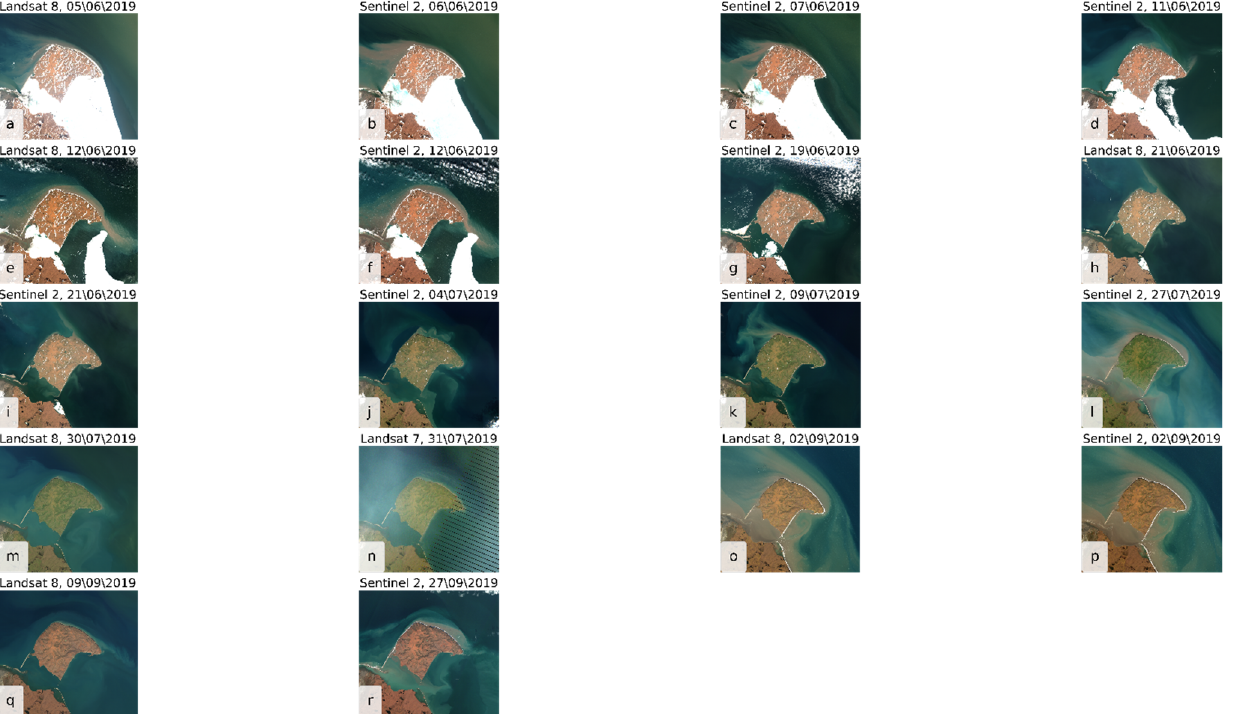
Figure A1. RGB composites of the satellite imagery similar to Figure 2. Figures a – f depict the ice break-up with increased turbidity. During mid-Summer (Figures g – n ), turbidity is decreased with one exception (l). During Fall (Figures o – r ), the turbidity features are unstable and change rapidly.